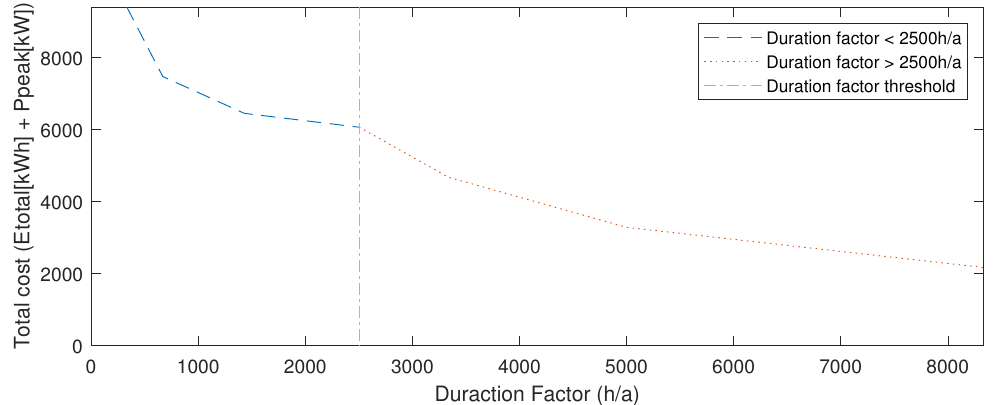
Figure 2. Network cost vs. duration factor at constant total energy consumption of 100 MWh in a given network area, medium voltage tariff, 2017.